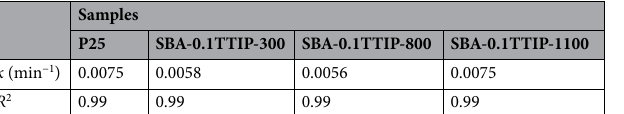
Table 3. Apparent first-order rate constant k for the decomposition of benzene and their corresponding global correlation coefficient R 2 value.